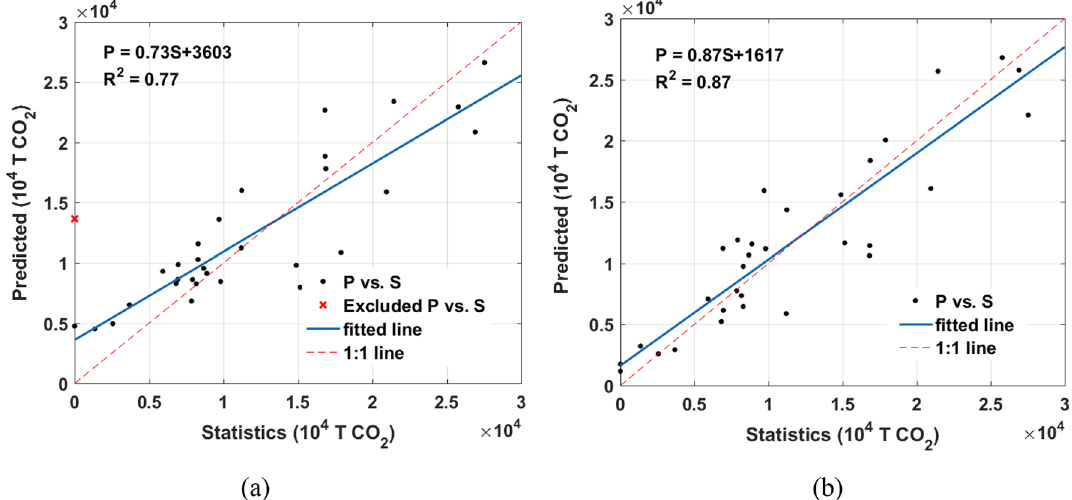
Figure 3. Trend line of the predicted (‘P’ for short) and the statistics (‘S’ for short) data at provincial level, ( a ) Model 1, ( b ) Model 2. The figs were generated using the MATLAB software package (The MathWorks, Version 2013, https:// www. mathw orks. com). The predicted data was summarized to provincial level using zonal statistics tool in ArcGIS. Two outliers were excluded because of the missing value in statistic